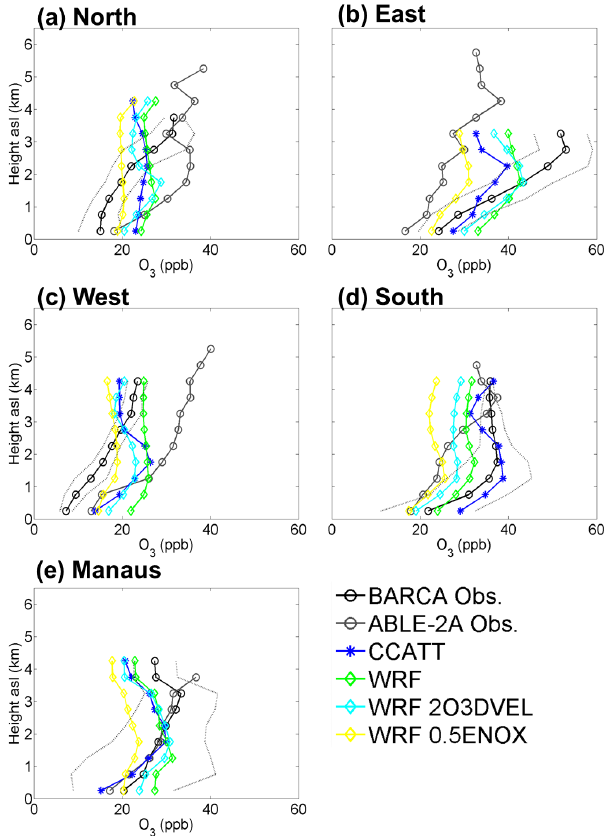
Figure 13. Mean vertical NO profiles corresponding to BARCA A flights for CCATT-BRAMS (blue) and WRF-Chem (base case: green, 2DEPVEL: cyan, and 0.5ENOx: yellow) simulations by re- gion: (a) north, (b) east, (c) west, (d) south, and (e) around Manaus. ABLE-2A observations (gray) from the same regions are included for